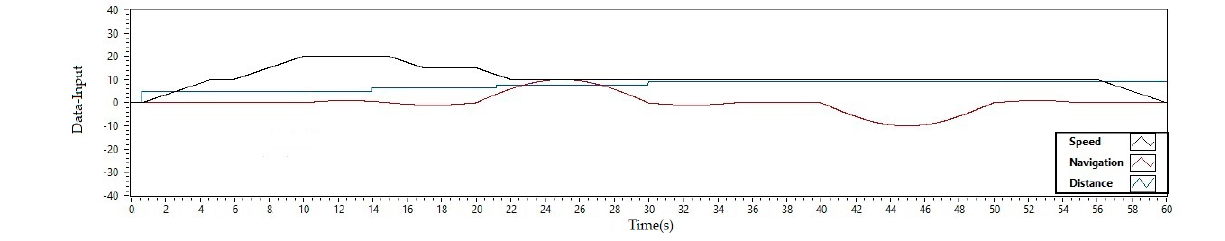
Figure 12. Input of system.